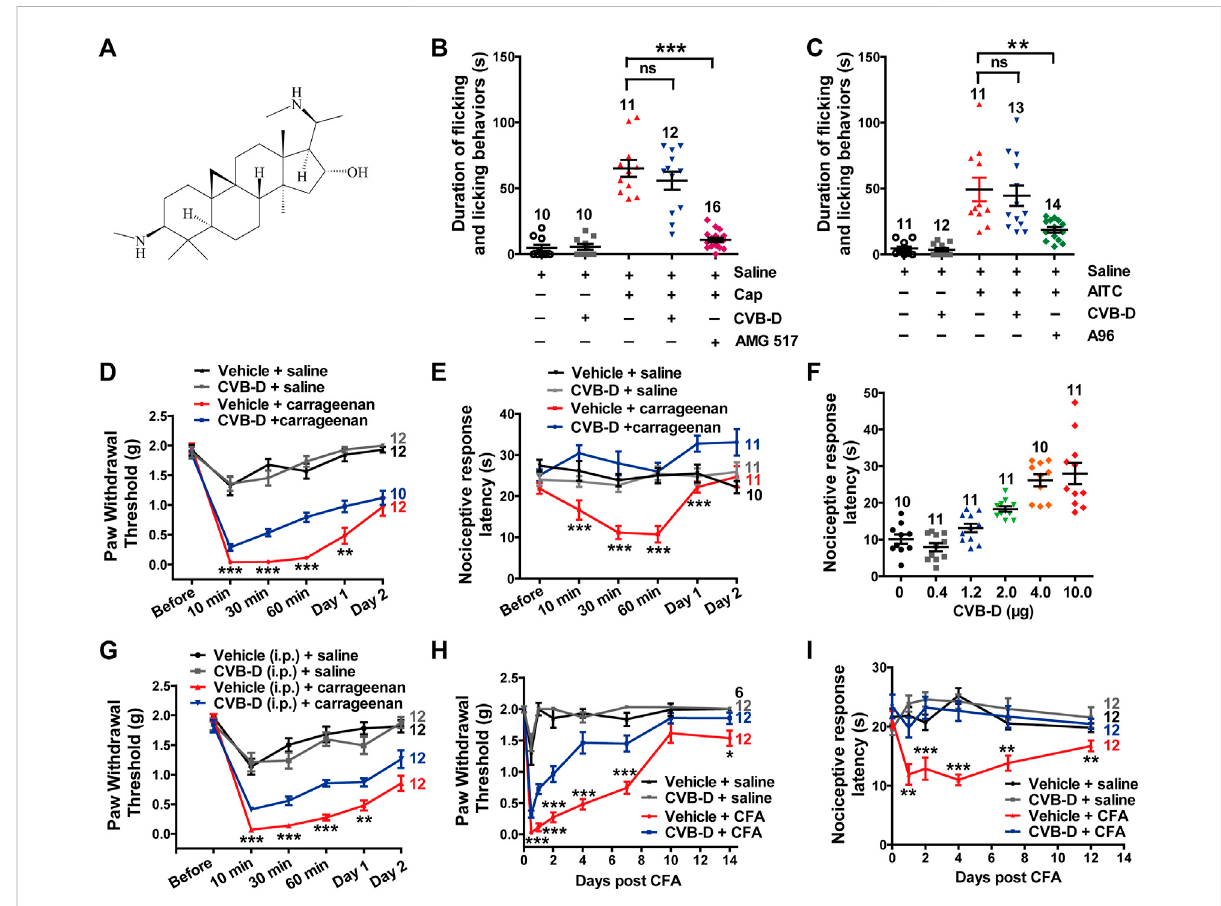
FIGURE 1 Effect of CVB-D on acute pain and in fl ammatory hypersensitivity in mouse models. (A) Chemical structure of CVB-D. (B) Effect of CVB-D on capsaicin (Cap)-induced acute pain. Saline (black) was used as a control for Cap (red), and vehicle (gray) was used as a control for CVB-D (blue). AMG517(3 mg/kg)treatmentwasmarkedaspurple.Timeofmicespentonlickingorliftingoftheinjectedhindpawswascountedwithin5 minafteri. pl. injection of saline for Saline (black) group, CVB-D for vehicle (gray) group, and Cap for the rest of groups. (C) Effect of CVB-D on AITC- induced acute pain. Saline (black) was used as a control for AITC (red), and vehicle (gray) was used as a control for CVB-D (blue). A-967079 (A96) treatment was marked as green. Animal behaviors were recorded using the same method as in Figure 1B. (D) Effect of CVB-D (i.pl. injection) on carrageenan-induced mechanical hypersensitivity. PWT was measured with von Frey fi laments at the indicated times after i. pl. injection of saline or carrageenan. Vehicle-saline (black) was used as a control for vehicle-carrageenan (red). CVB-D-saline (gray) was used as a control for CVB-D- carrageenan(blue).StatisticalanalysiswasperformedbetweenthegroupsofCVB-D-carrageenanandvehicle-carrageenan. (E) EffectofCVB-D(i.pl. injection) on carrageenan-induced thermal hypersensitivity. Same grouping as in Figure 1D. PWL was measured using the hot plate assay at the indicated times after i. pl. injection of saline or carrageenan. Statistical analysis was performed between the groups of CVB-D-carrageenan and vehicle-carrageenan. (F) Dose-effect of CVB-D ’ s (i.pl. injection) suppression on carrageenan-induced thermal hypersensitivity. Each scatter plot shows the PWL of animals received different dosage of CVB-D at 30 min after carrageenan injection. (G) Effect of CVB-D (i.p. injection) on carrageenan-induced mechanical hypersensitivity. Same experimental procedures as in Figure 1D, except that CVB-D and itscorresponding vehicle were intraperitoneally injected 30 min prior to the i. pl. injection of carrageenan. Statistical analysis was performed between the groups of CVB-D- carrageenanandvehicle-carrageenan. (H) EffectofCVB-D(i.pl.injection)onCFA-inducedmechanicalhypersensitivity.PWTwasmeasuredwithvon Frey fi laments within a 2-week period after i. pl. injection of saline or CFA. Vehicle-saline (black) was used as a control for vehicle-CFA (red). CVB- D -saline (gray) was used as a control for CVB-D-CFA (blue). Statistical analysis was performed between the groups of CVB-D-CFA and CFA-vehicle. (I) Effect of CVB-D (i.pl. injection) on CFA-induced thermal hypersensitivity. Same grouping as same in Figure 1H. PWL was measured using the hot plate assay at the indicated days after i. pl. administration of saline or CFA. Statistical analysis was performed between the groups of CVB-D-CFA and CFA-vehicle. Data information: The number in each graph indicates the number of mice used in each experiment. Statistical signi fi cance was evaluated using two-tailed t -test(for two-group comparisons),with * p < 0.05, ** p < 0.01, and *** p < 0.001; ns indicates nosigni fi cance. Theexact t, F, and p -values are indicated in Appendix Table S1. All the data are presented as mean ±